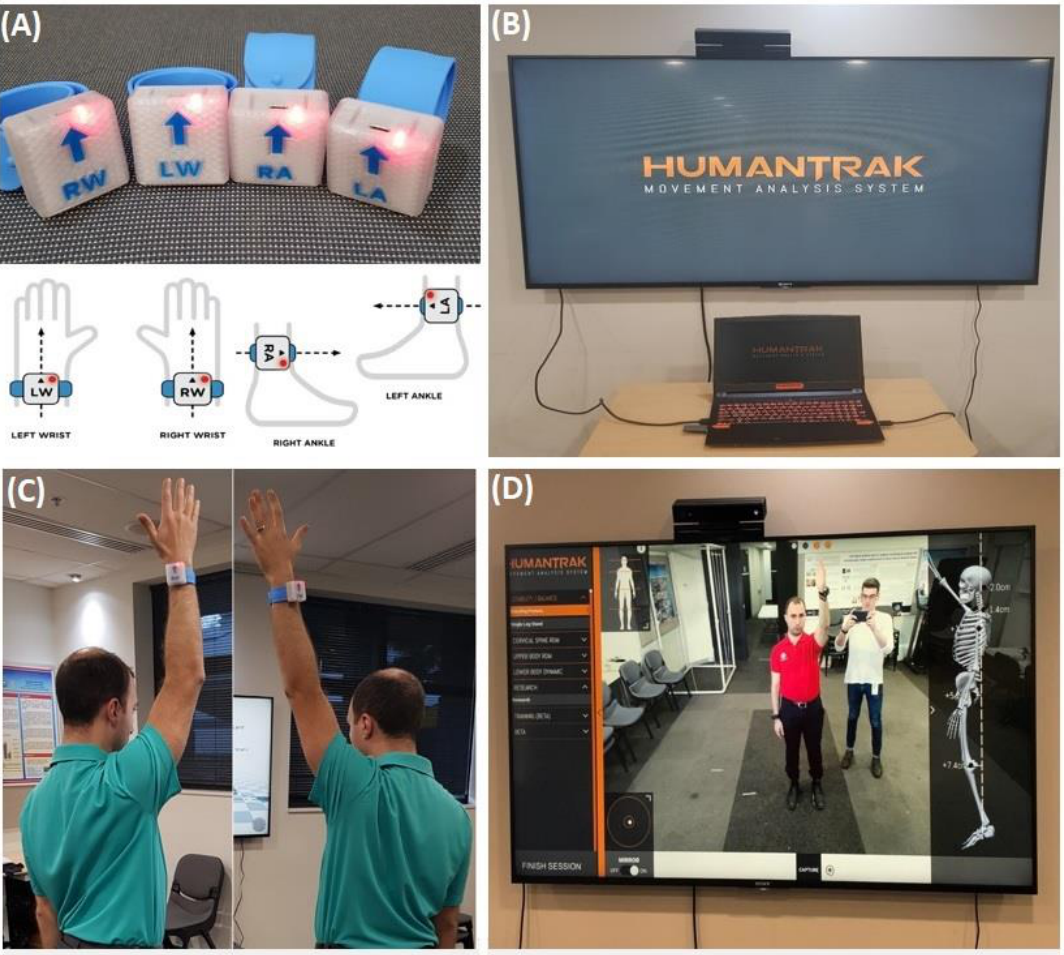
Figure 1. The HumanTrak system. ( A ) Inertial sensors. ( B ) Microsoft Kinect (v2) positioned above a television screen and connected to a laptop. ( C ) Shoulder-free active range of motion (AROM) demonstration. ( D ) HumanTrak interface.